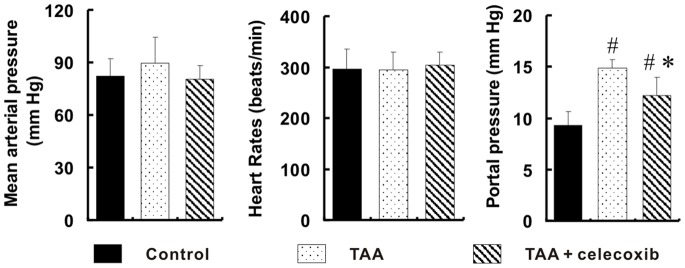
Decrease of portal hypertension by celecoxib treatment.There were no significant differences of the mean arterial pressure and heart rate among three groups, p>0.05. The portal pressure measured by introduced catheters in TAA group was the highest among three groups. # p<0.01 vs. control group; * p<0.01 vs. TAA group.